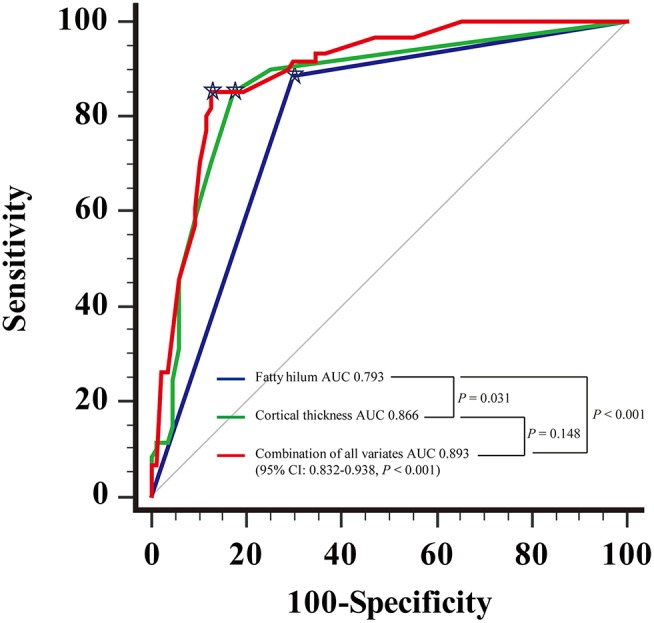
Receiving operating characteristic (ROC) curve analysis showed combination of all the imaging parameters and comparison of Areas under the curve (AUC).  Showed the optimal cutoff.